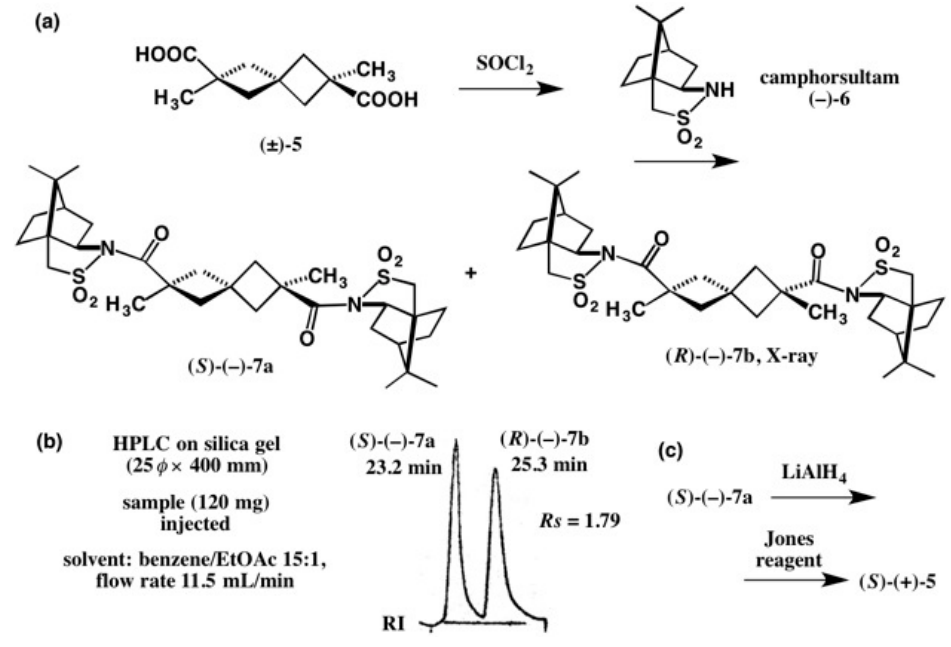
Figure 6. Preparation of diastereomeric amides 7a and 7b ( a ), separation by HPLC on silica gel ( b ), and recovery of acid ( S )-(+)- 5 ( c ). HPLC, redrawn from [22].